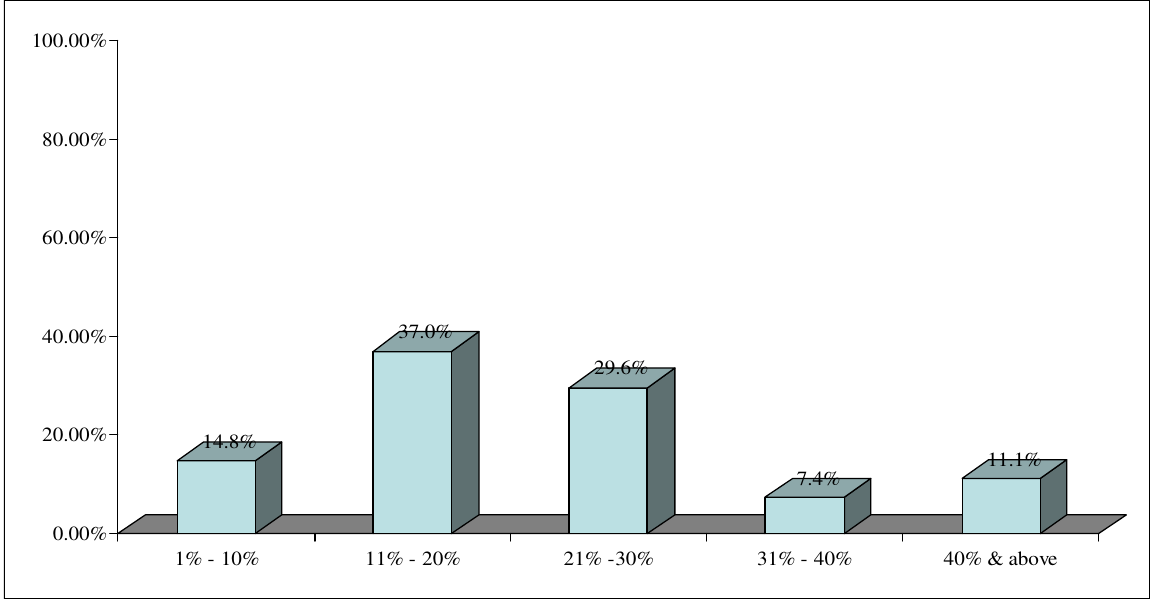
Fig. 3. Percentage of cases caused by reckless